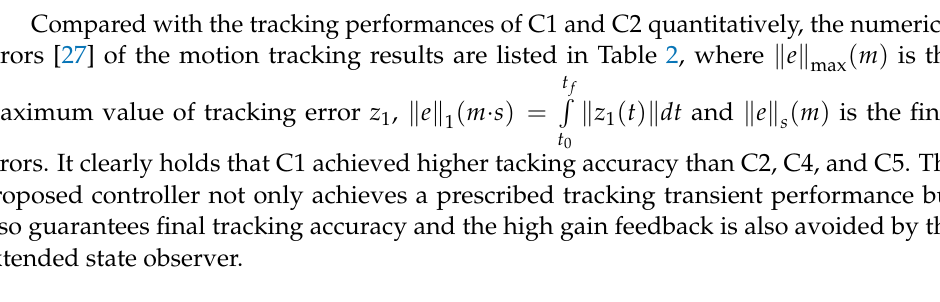
Figure 8. Volume changes of V1 and V2 in one period of motion.